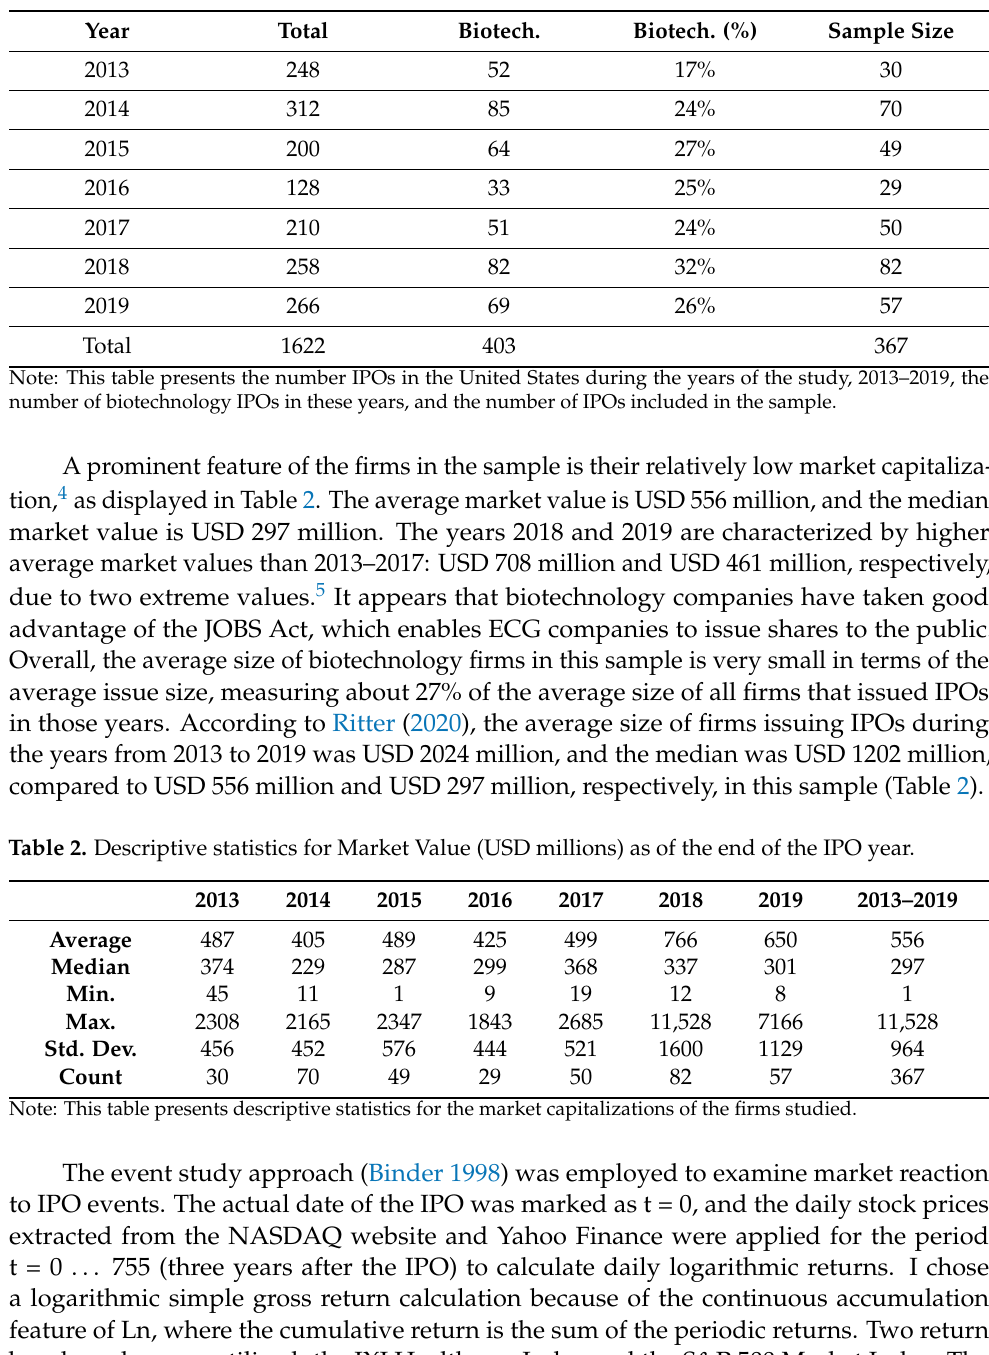
Table 1. Number of IPOs per year.